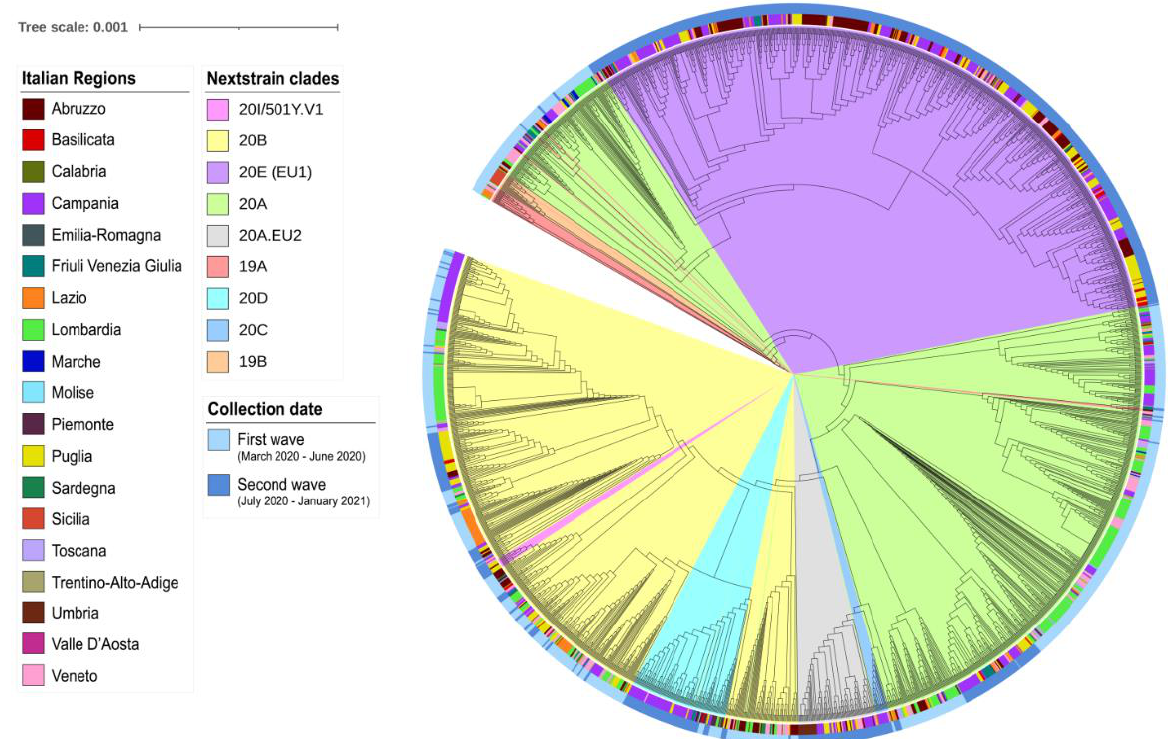
Figure 2. Phylogenetic tree showing the relationship between the 2244 Italian SARS-Cov-2 genome sequences. The tree was inferred with the approximate maximum likelihood method as implemented by FastTree v2.1 [21] and decorated with iTOL. Nextstrain clades are highlighted in pastel colors. The Italian region of sample collection is shown across the inner colored strip, the outer circle displays the sampling date, sorted into first wave and second wave. A newick (plain text) version of the phylogenetic tree, with branch lengths and support values at nodes, is reported in Supplementary File 2.